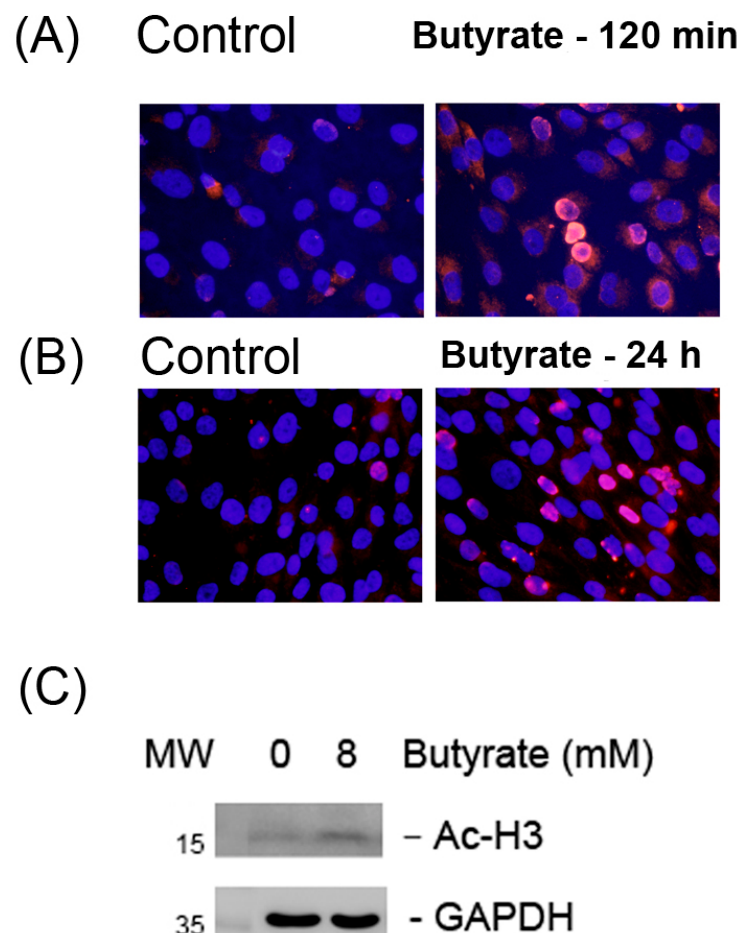
Figure 1. The stimulation of the histone H3 acetylation of MG63 cells as analyzed by immunofluorescent staining (IF) and Western blotting. ( A ) IF pictures of Ac-H3 expression: Control (120 min) and butyrate (8 mM)-treated MG-63 cells for 120 min. ( B ) IF pictures of Ac-H3 expression: Control (24 h) and butyrate (8 mM)-treated MG63 cells for 24 h, 400 × , original magnification, ( C ) Western blotting of control and 8 mM butyrate-treated MG-63 cells for 24 h. One representative IF study result was shown. GADPH: Glyceroaldehyde-3-dehydrogenase. MW: Molecular weight (KD).